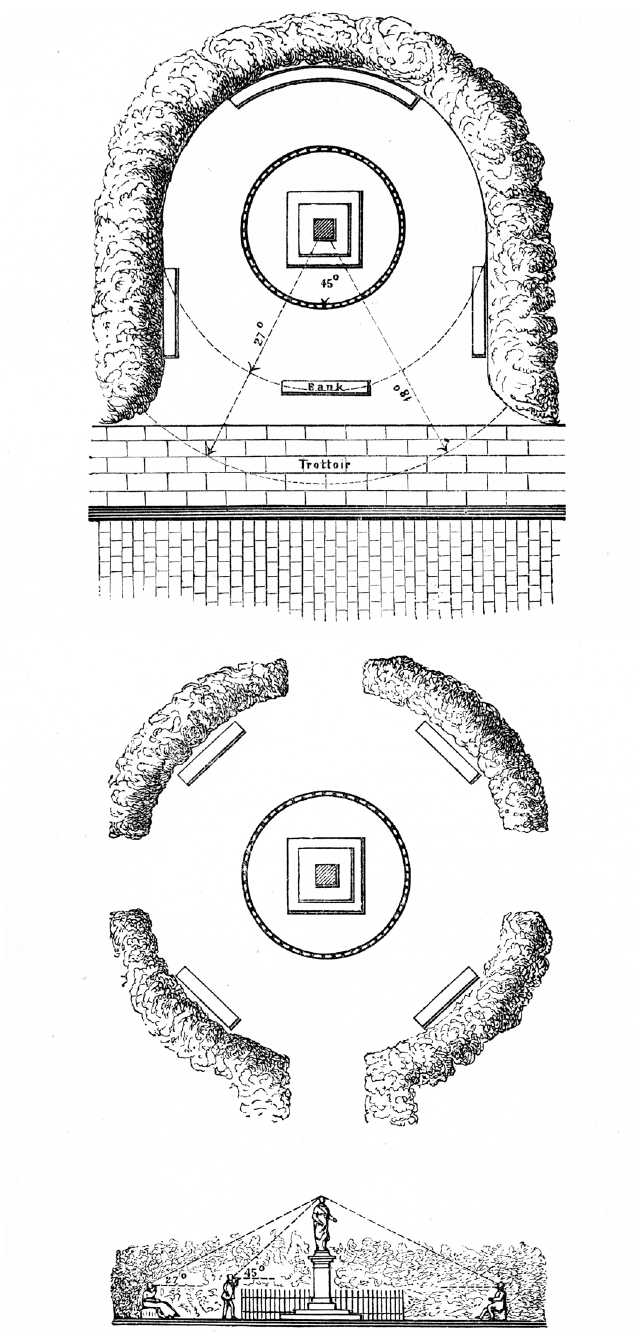
Fig. 3 Hermann Maertens, Der Optische-Maassstab, Maertens’ design of a garden around a monument through the application of 18, 27 and 45 degrees visual angles (Maertens,